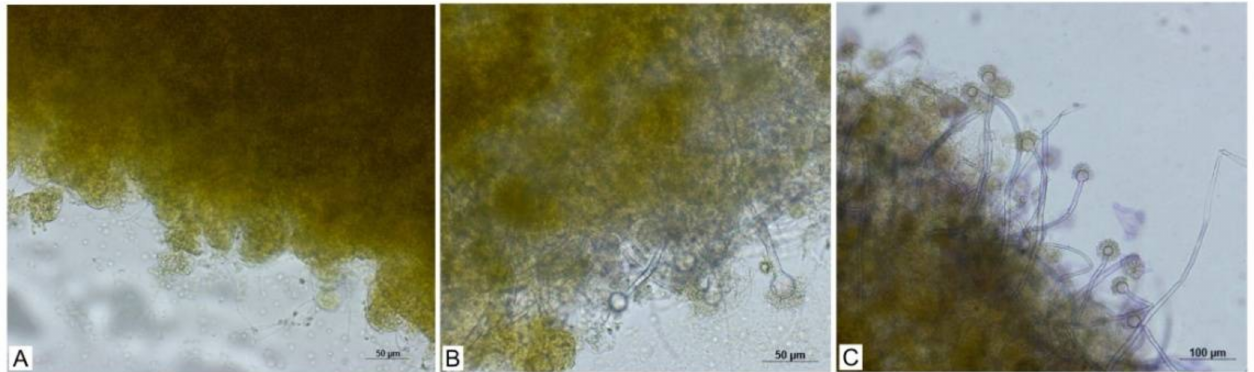
Figure 3. A . niger pellets with Chlorella sp. after cultivation on a shaker ( A ), detail of the “hairy region” of the A. niger pellet with Chlorella sp. ( B ).